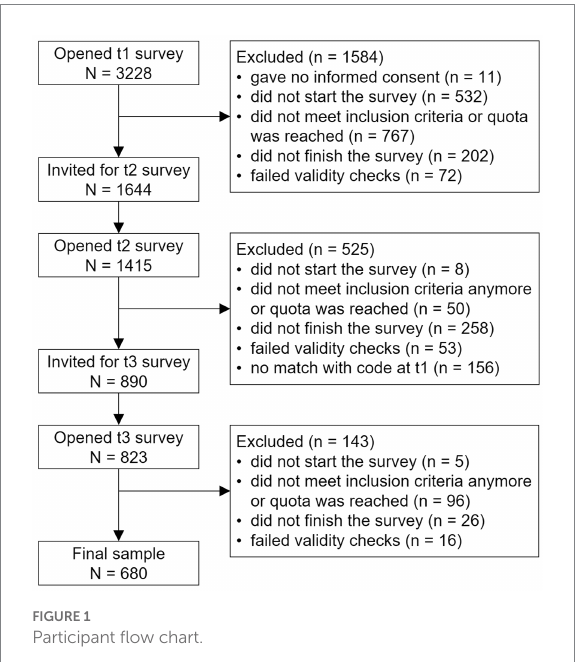
FIGURE 1 Participant flow